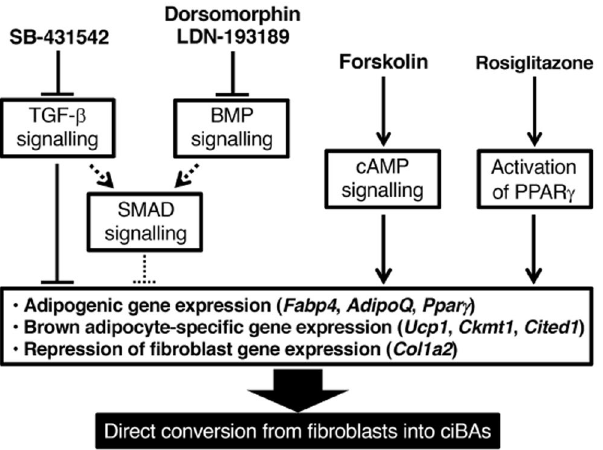
Figure 6. A schematic model for a possible connection between signalling pathways regulated by each chemical compound and the direct conversion into ciBAs from human dermal fibroblasts. Our results obtained using SB-431542, an inhibitor of TGF- β signalling pathway, suggest that TGF- β signalling pathway negatively regulates adipogenesis, and that the removal of SB-431542 from the chemical cocktails strongly suppressed the conversion efficiency. BMP signalling pathway regulated by the inhibitors, LDN-193189 and Dorsomorphin, is likely involved in modulation of the activity of downstream SMAD proteins shared with TGF- β signalling pathway. Cellular cAMP induction by Forskolin is closely associated with the activation of Ucp1 and other thermogenic genes through several kinases. Rosiglitazone plays a critical role in adipogenesis for both white and brown adipocytes through PPAR γ activation. The chemical combination of 5CD-GM and rosiglitazone might promote gene expression of adipogenic genes and brown adipocyte-specific genes in a coordinated manner, which might be associated with a stable conversion into ciBAs from human dermal